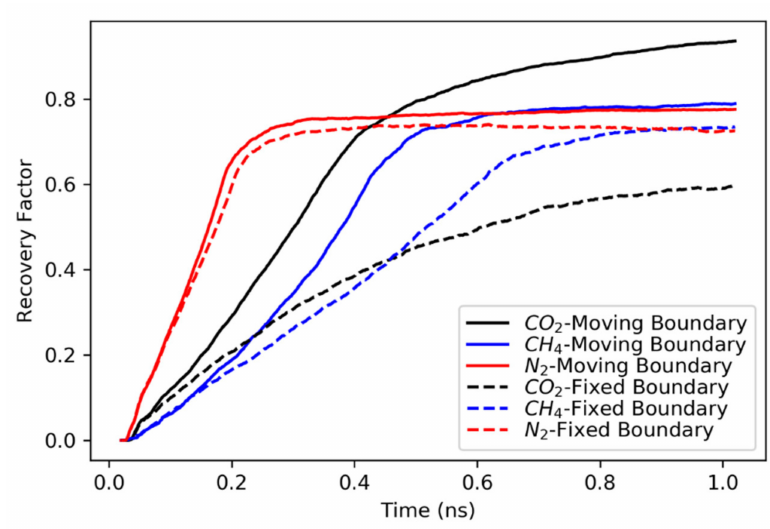
Figure 4. Recovery factors for single-component hydrocarbon systems.